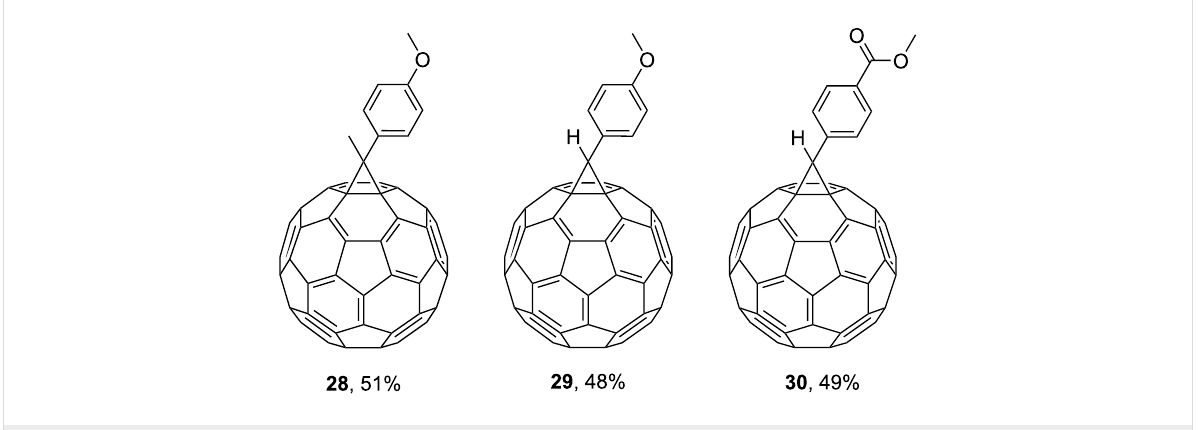
Figure 2: Structures of monophenyldiazomethanes 28 – 30 .